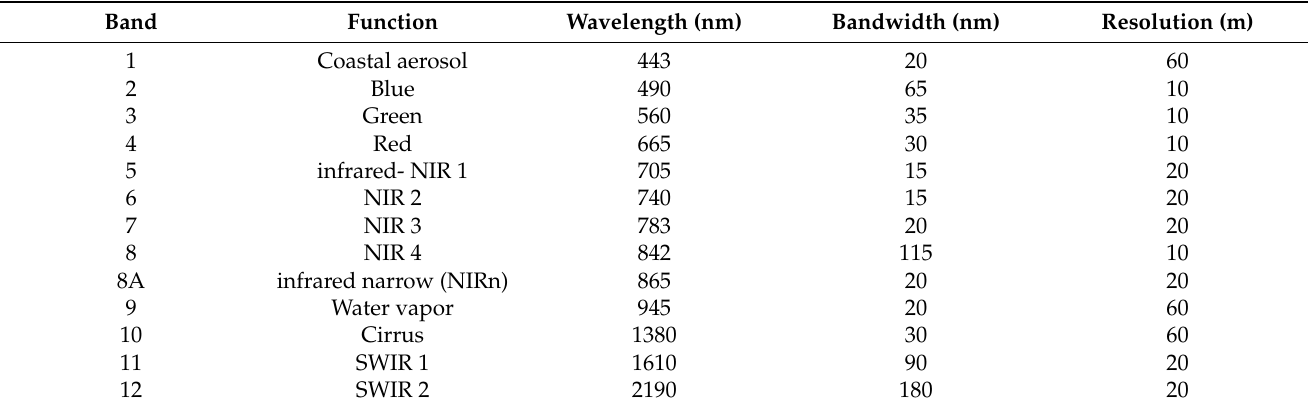
Table 1. Sentinel-2 bands